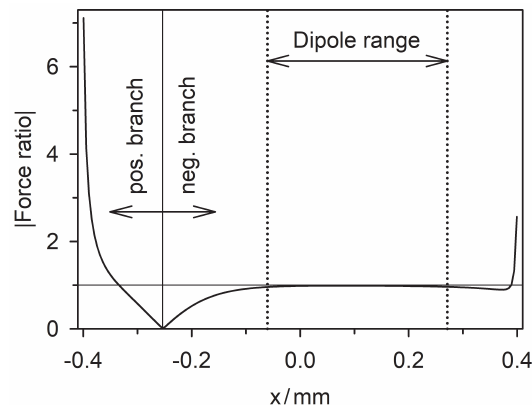
Figure 7. Absolute value of the quotient of the normalized DEP forces acting on the 1.0 S and 0.1 S spheres plotted along the symmetry line of the chambers (trajectories d and f of Figure 5 and trajectory f of Figure